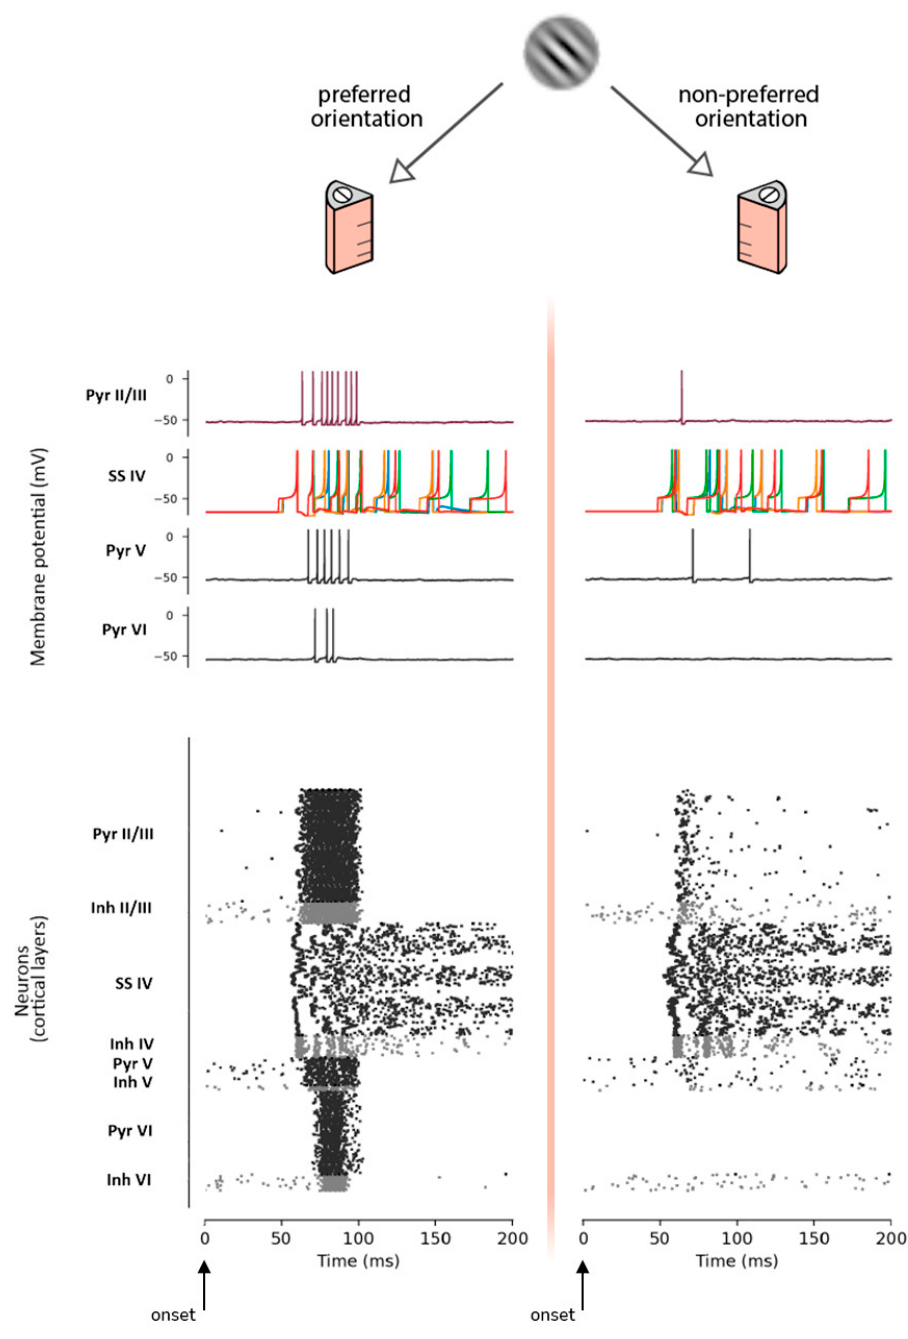
Figure 6. Response to the same Gabor patch (45 ◦ ) operated by a cortical column with that preferred orientation (i.e., column 45 , left) and a cortical column trained for the related orthogonal orientation (i.e., column 135 , right). Top: scheme of the presentation. Middle: plot of the membrane potential of a MNSD structure (target pyramidal neuron of layer II/III, related 4 SS neurons of layer IV) and single pyramidal neurons of layers V and VI. Bottom: raster plot of the whole oriented column showing the firing activity (excitatory in black and inhibitory in gray).